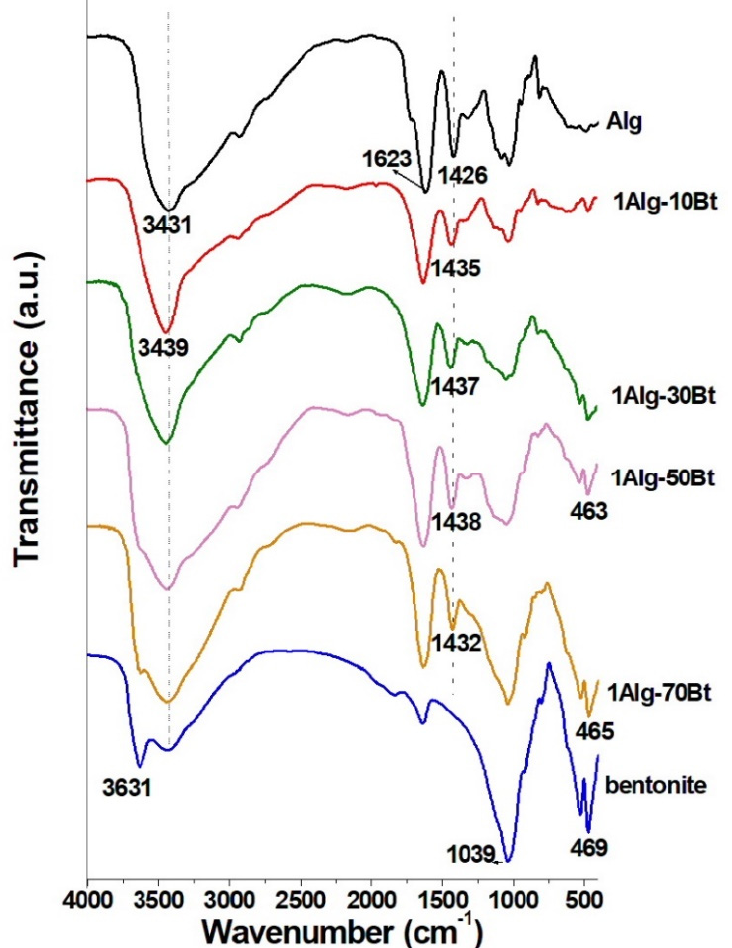
Figure 1. FTIR spectra of the alginate–bentonite composite aerogel. In the infrared spectrum of sodium alginate, 3431 cm − 1 is the hydroxyl stretching vibration peak, 1623 and 1426 cm − 1 are the asymmetrical and symmetrical stretching vibration peaks of COO–, 1087 cm − 1 is the vibration peak of C–O–C, and 1032 cm − 1 is the C–O stretching vibration peak of C–O on the pyranosyl ring. Obviously, the characteristic peaks of bentonite and sodium alginate appeared in the spectra of the composite aerogel, and with the increase in the bentonite content in the composites, the peak strength of the characteristic absorption peak at 1039 cm − 1 of bentonite also increased. In addition, it can be seen from the spectra that the peak shape of the composite aerogel was similar to that of sodium alginate when the bentonite content was